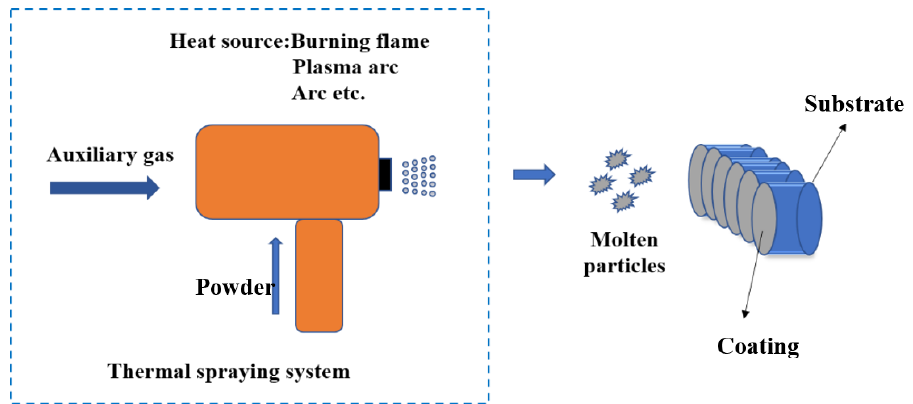
Figure 1. Schematic diagram of the plasma spraying process.